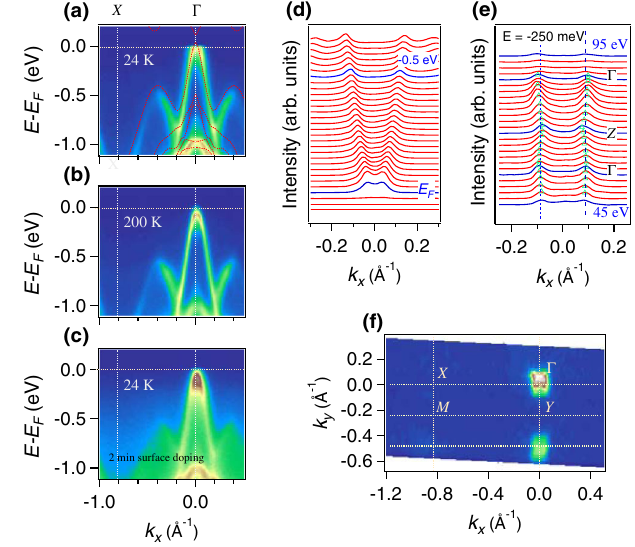
FIG. 2. Band structure of pristine ZrTe 5 . (a) Band dispersions along Γ − X measured at 24 K. For comparison, the calculated band structure along Γ − X is plotted on top of the experimental data. The calculated bands are shifted up by 70 meV to match the experimental data. (b) Same as (a) but recorded at 200 K. (c) Same as (a) but measured after the deposition of potassium atoms for 2 min. (d) Momentum distribution curve plot of (a) showing two peaks at E F , confirming the E F crossing of the valence bands. (e) Momentum distribution curves at − 250 meV recorded with different incident photon energies from 45 to 95 eV. (f) Fermi surface intensity plot measured on the (010) surface at 24 K showing a small hole pocket at Γ . The directions of k x and k y are parallel and perpendicular to the ZrTe 3 chains in the (010) plane, respectively, while k z is along the (010) surface normal